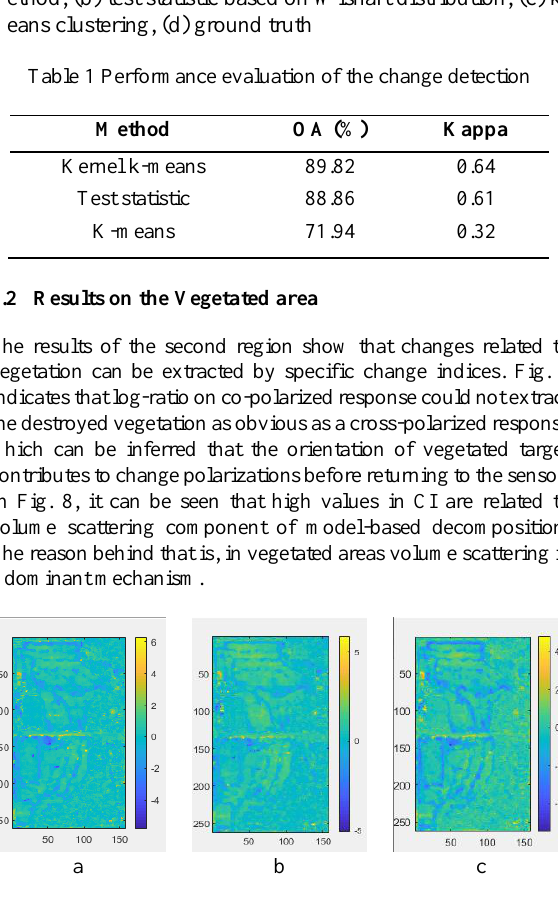
Fig. 7. Change indices in region 2 based on, (a) log-ratio HH, (b) log-ratio VV, (c) log-ratio VH